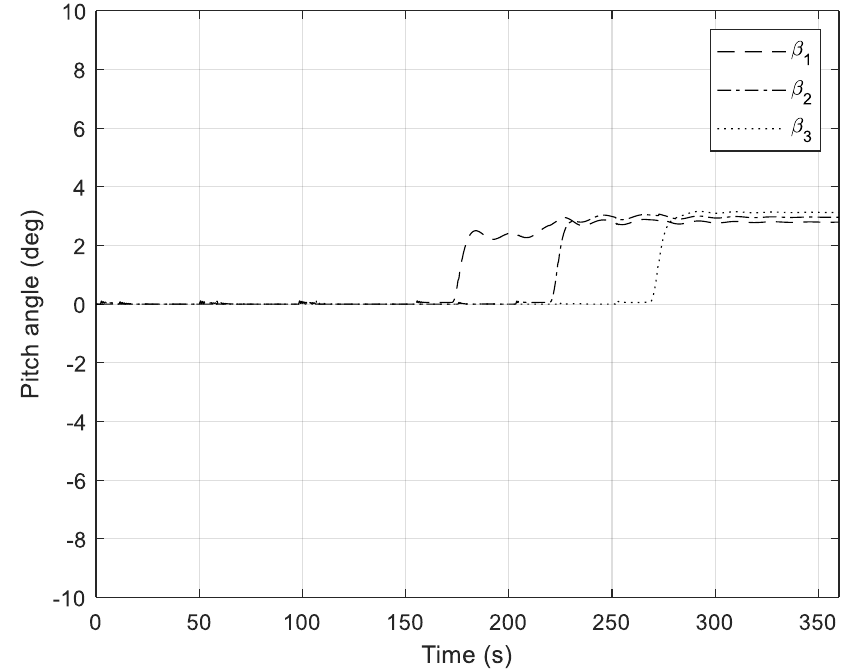
Figure 12. Power coefficient C p of the wind turbines.